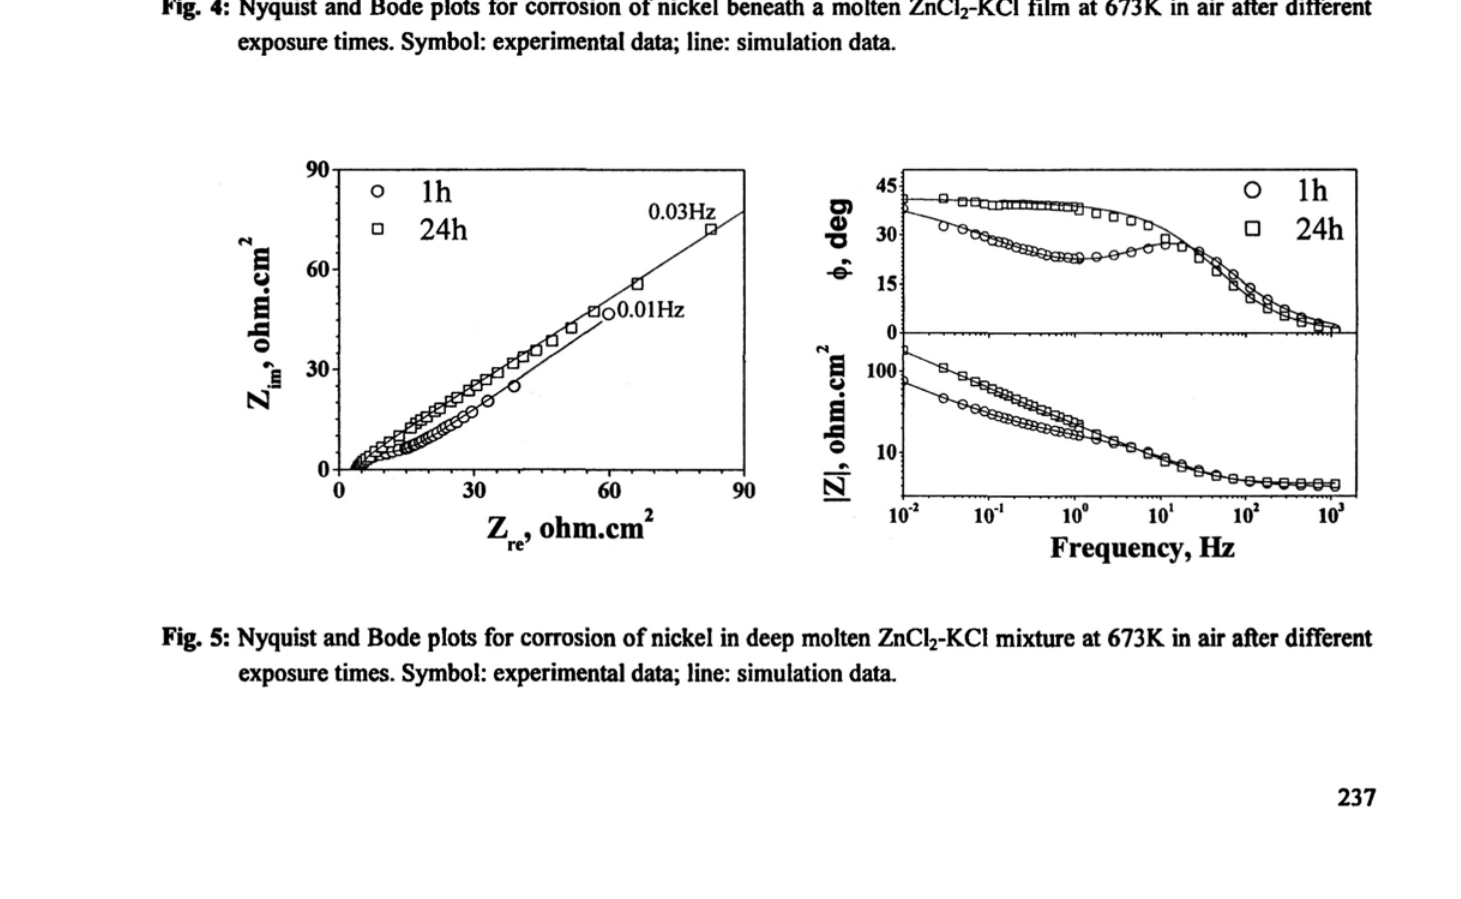
-KCl film at 673K in air after different 2